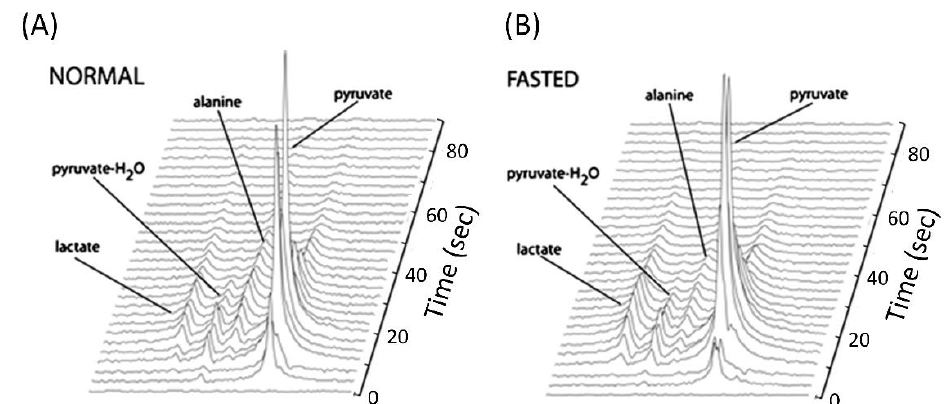
Figure 4. Dynamic hyperpolarized 13 C MR spectra of the in vivo liver of fed ( A ) and fasted rats ( B ). Acquisition started after intravenous administration of hyperpolarized [1- 13 C]pyruvate, and spectra were collected every 3 s. The production of [1- 13 C]alanine was significantly lower in the fasted liver compared to that in the fed state. This figure was adapted from Reference [63], with permission.